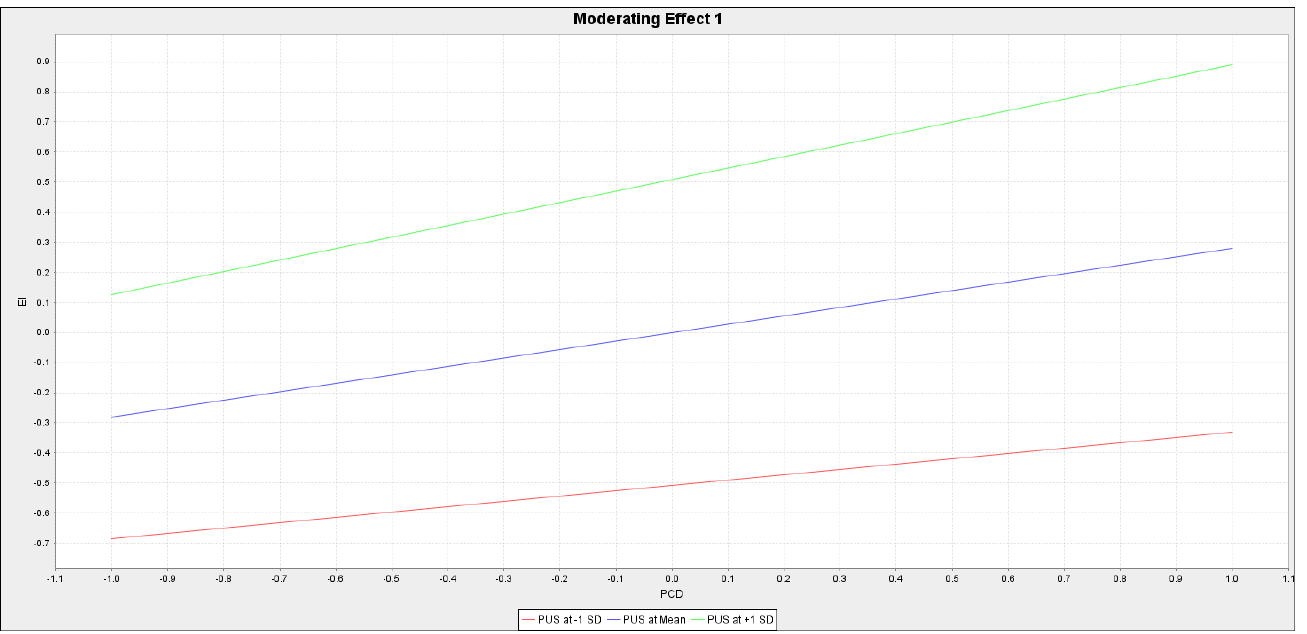
Figure 2. Slope plot for moderation analysis .